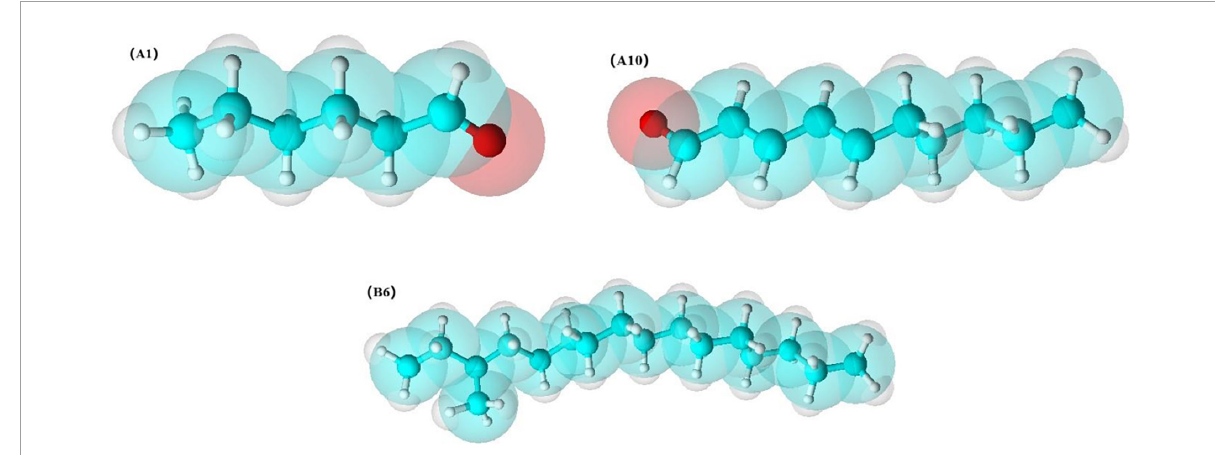
FIGURE9 Molecular structure diagram of hexanal, (E,E)-2,4-decadienal and